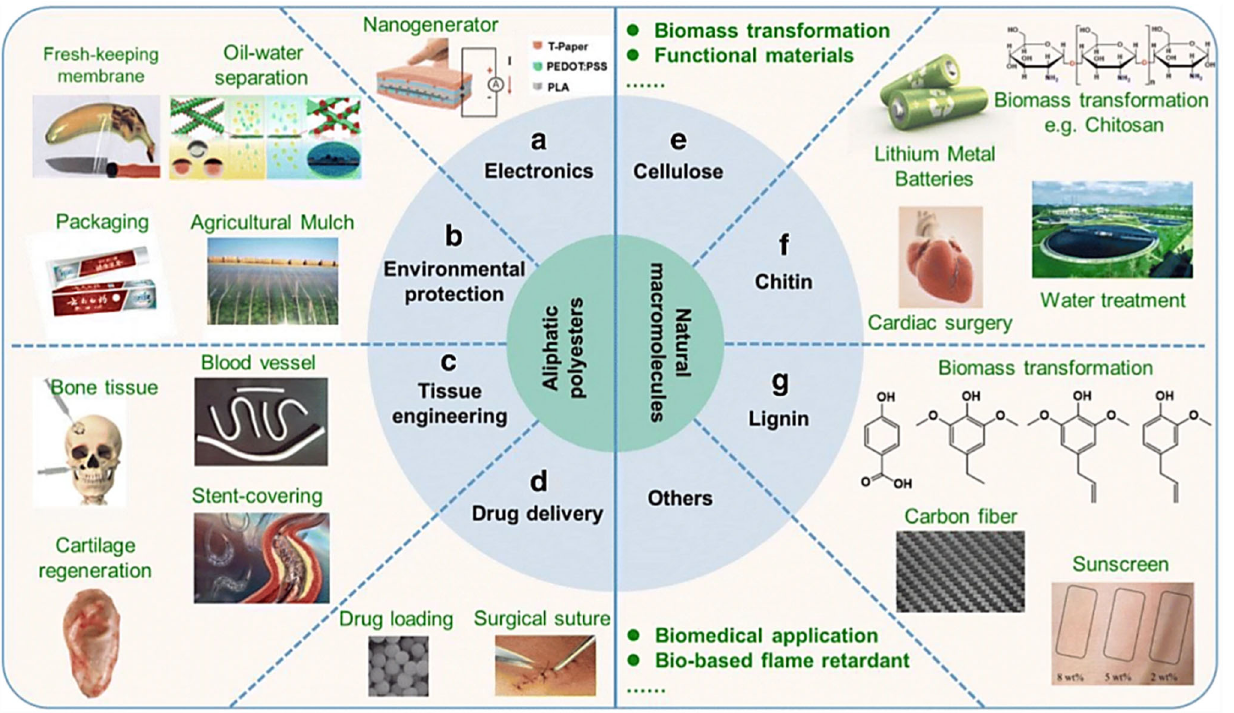
Fig. 7 Applications of biodegradable materials. Snapshot of the main fi elds of application 101